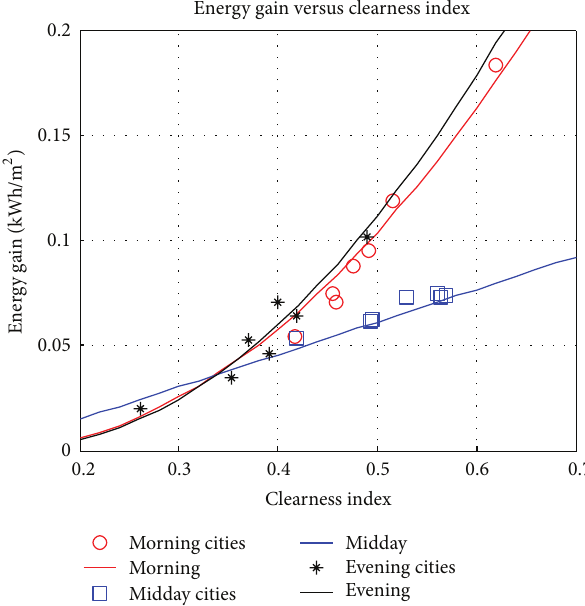
Figure 15: Energy gain of DAST over SSS on 3 segments period.